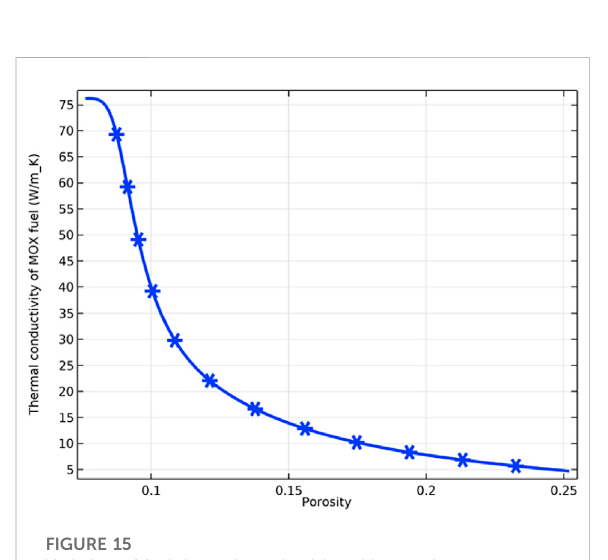
FIGURE 16 Variation of fuel inner surface temperature with fuel burnup for initial porosity of 0.03, 0.08 and